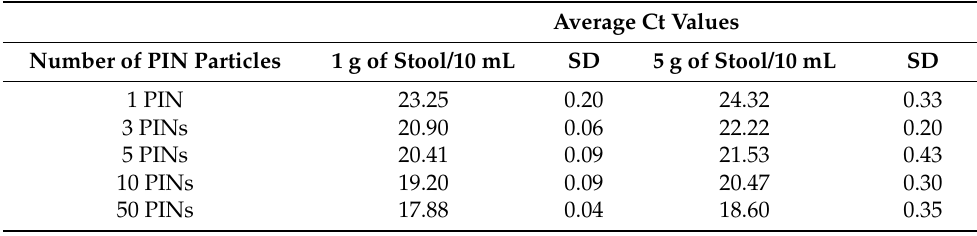
Table 3. The number of PIN particles against matrix